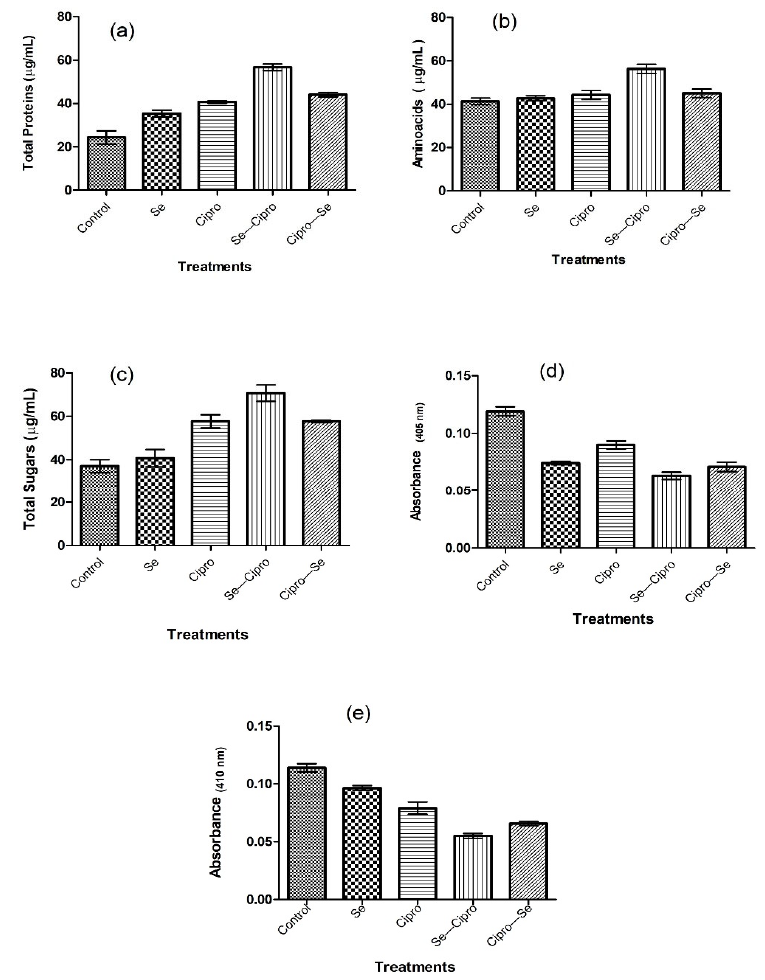
Figure 5. Graphs of bioassays after the different treatments of selenium nanoparticles (Se) and ciprofloxacin (Cipro) given to Acanthamoeba trophozoites; ( a ) Protein leakage; ( b ) Amino acid leakage; ( c ) Total sugar leakage; ( d ) Galactosidase inhibitions; ( e ) Protease inhibition.